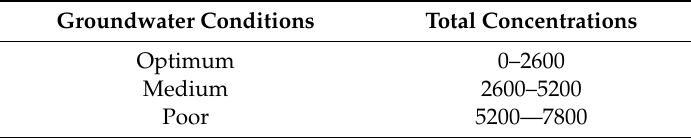
Table 4. Groundwater conditions and the corresponding total